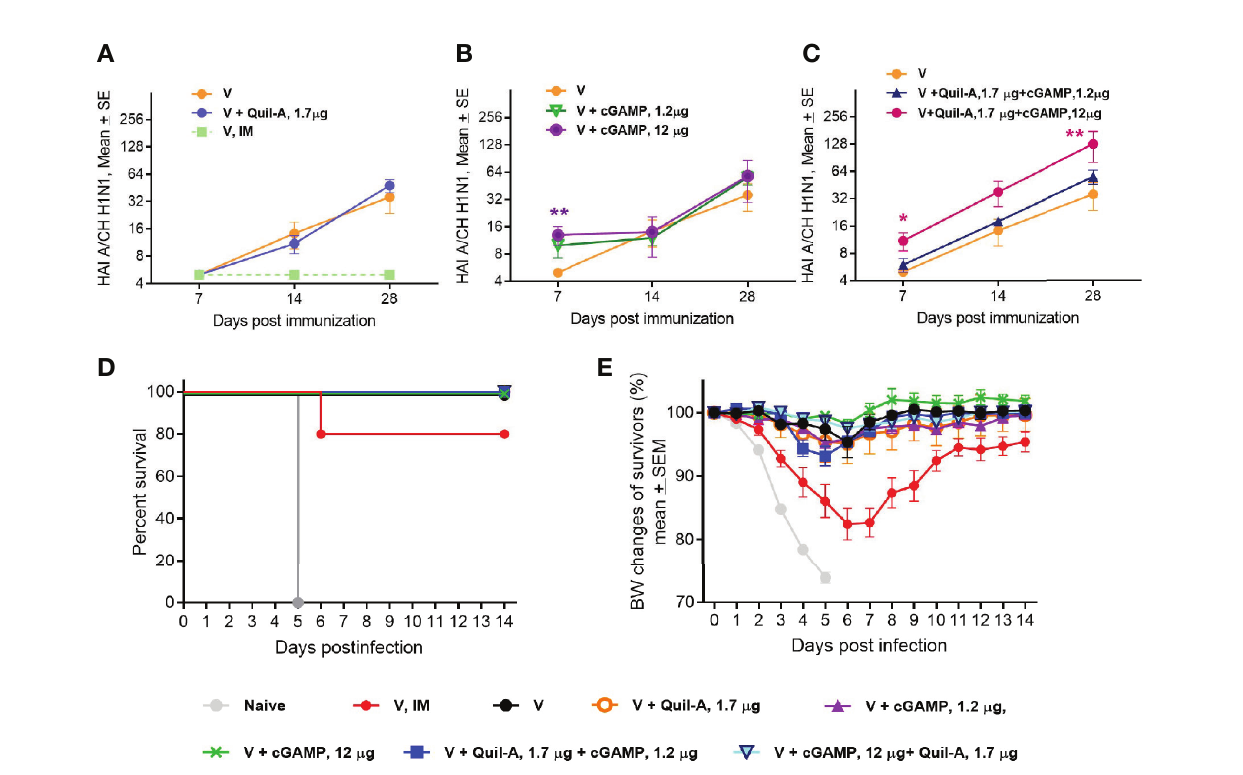
FIGURE 1 | Effect of MNP vaccination in young adult 10-week-old mice (n=5 in all groups except the unadjuvanted MNP group, where n = 7). Mice were immunized once with A/Christchurch H1N1/16/10 (H1N1) vaccine alone or in combination with adjuvants by the IM route (1.2 µg HA, group V, IM) or through skin with MNP (1.3 ± 0.4 µg HA, all other groups). HAI titers were measured against A/Christchurch H1N1/16/10 (H1N1) virus. (A) HAI titers in mice immunized with unadjuvanted vaccine either IM or by MNPs or with MNPs which co-incorporated 1.2 µg of Quil-A with the vaccine; (B) HAI titers in mice MNP-vaccinated with either unadjuvanted vaccine or with vaccine combined with high (12 µg) or low (1.2 µg) doses of cGAMP; (C) HAI titers in mice MNP-vaccinated with either unadjuvanted vaccine or adjuvanted with a combination of cGAMP and Quil-A. The statistical signi fi cance between unadjuvanted and adjuvanted groups calculated by one-way ANOVA with Tukey ’ s posttest at the same time points postvaccination is represented by stars (*p < 0.05, **p < 0.01) (D) Survival of vaccinated mice challenged with a 47xLD 50 dose of mouse-adapted A/California 07/09 H1N1virus. All mice were immunized with MNPs except for one group vaccinated with the unadjuvanted vaccine intramuscularly (V, IM). (E) Changes in body weight of vaccinated mice after challenge. Note that all unvaccinated mice succumbed to infection while all MNP- vaccinated mice survived. In the inadjuvanted IM group one mouse reached 25 % weight loss threshold at day 6 post challenge and was humanely